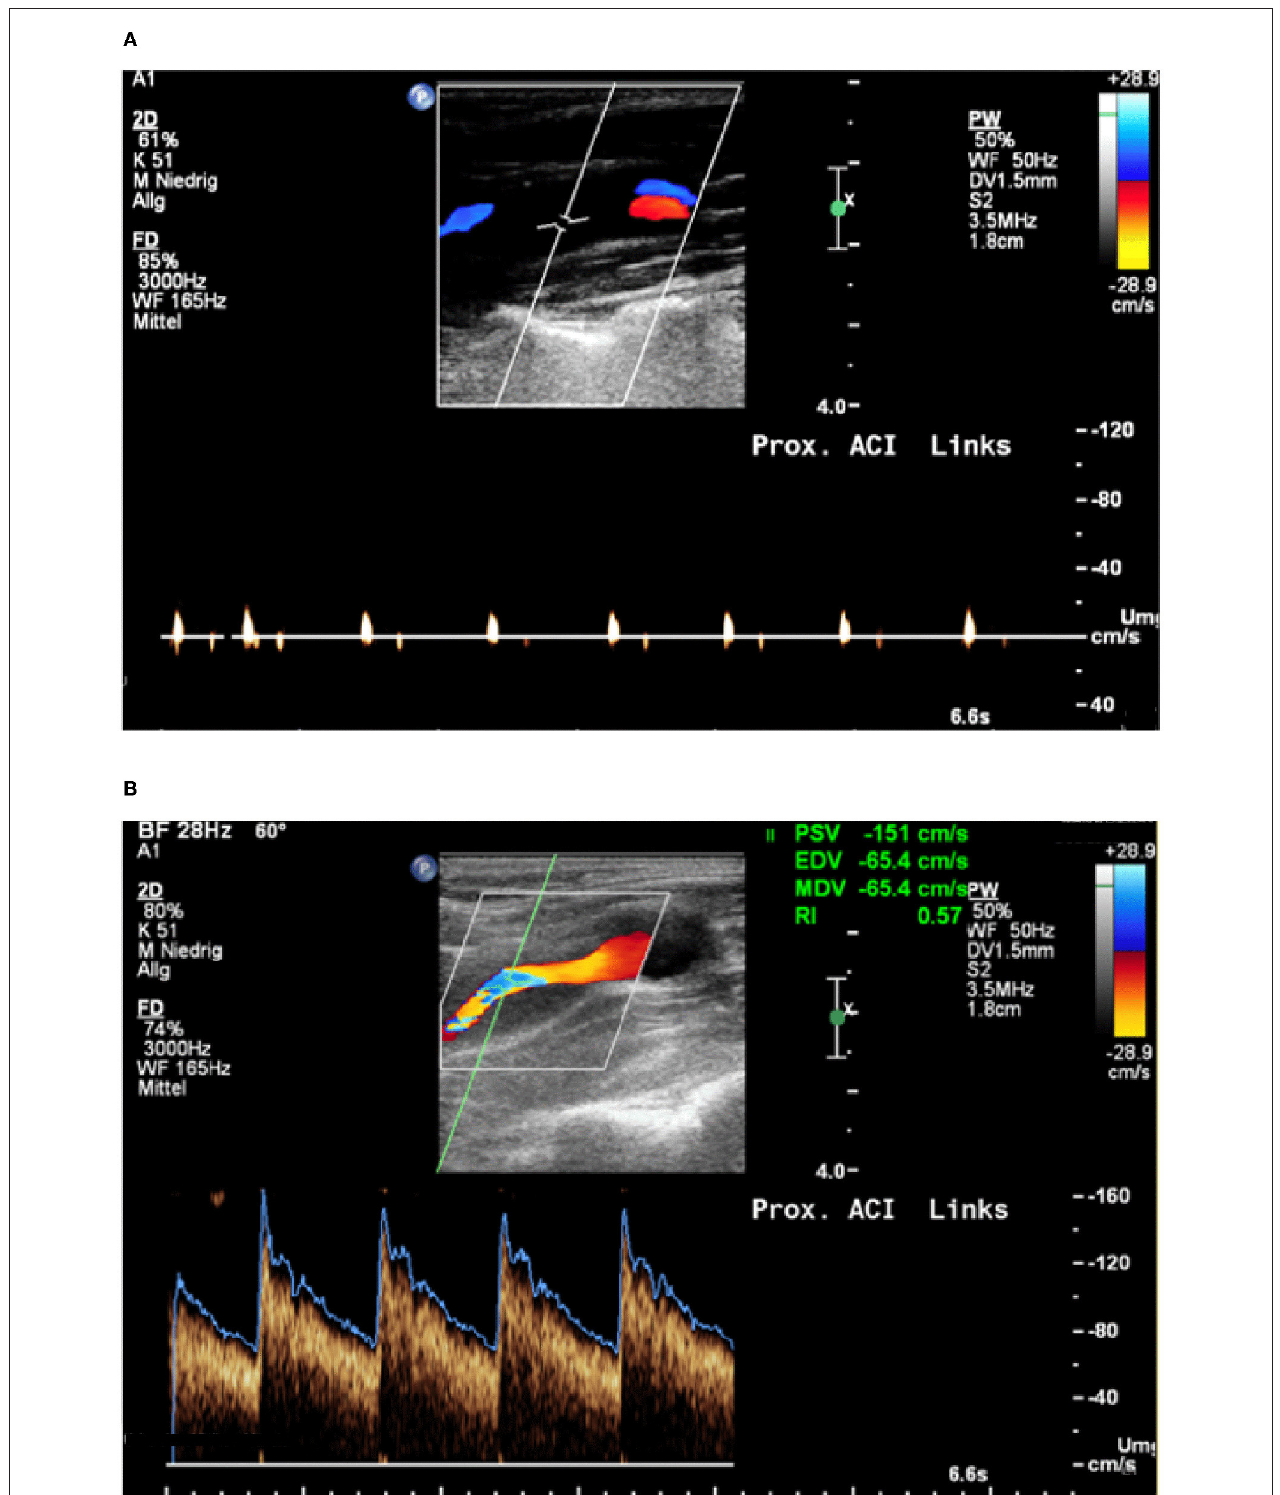
FIGURE 2 | (A) 42-year-old patient with transient aphasia, paresthesia on the right, Horner syndrome on the left; Occlusion signal indicates occlusion of the internal carotid artery. (B) Neurovascular ultrasound done 3 days later shows recanalization with evidence of a wall hematoma.